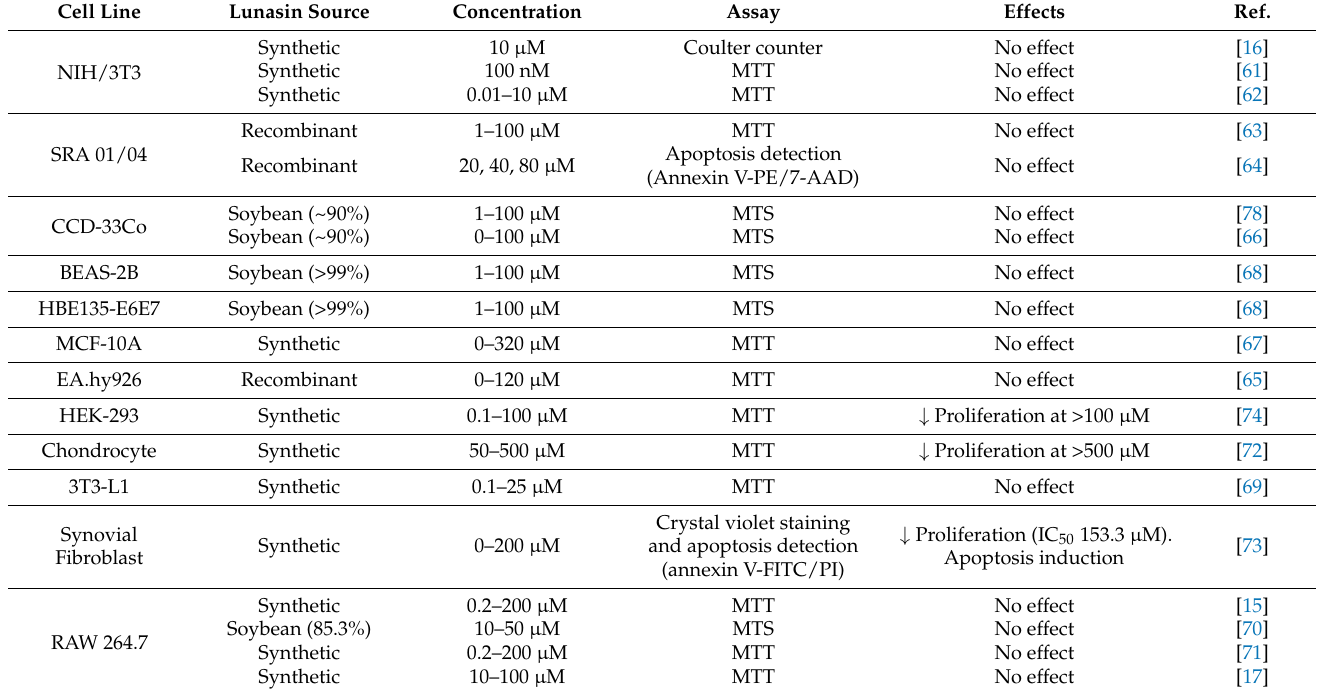
Table 2. Lunasin activity against normal and immortalized